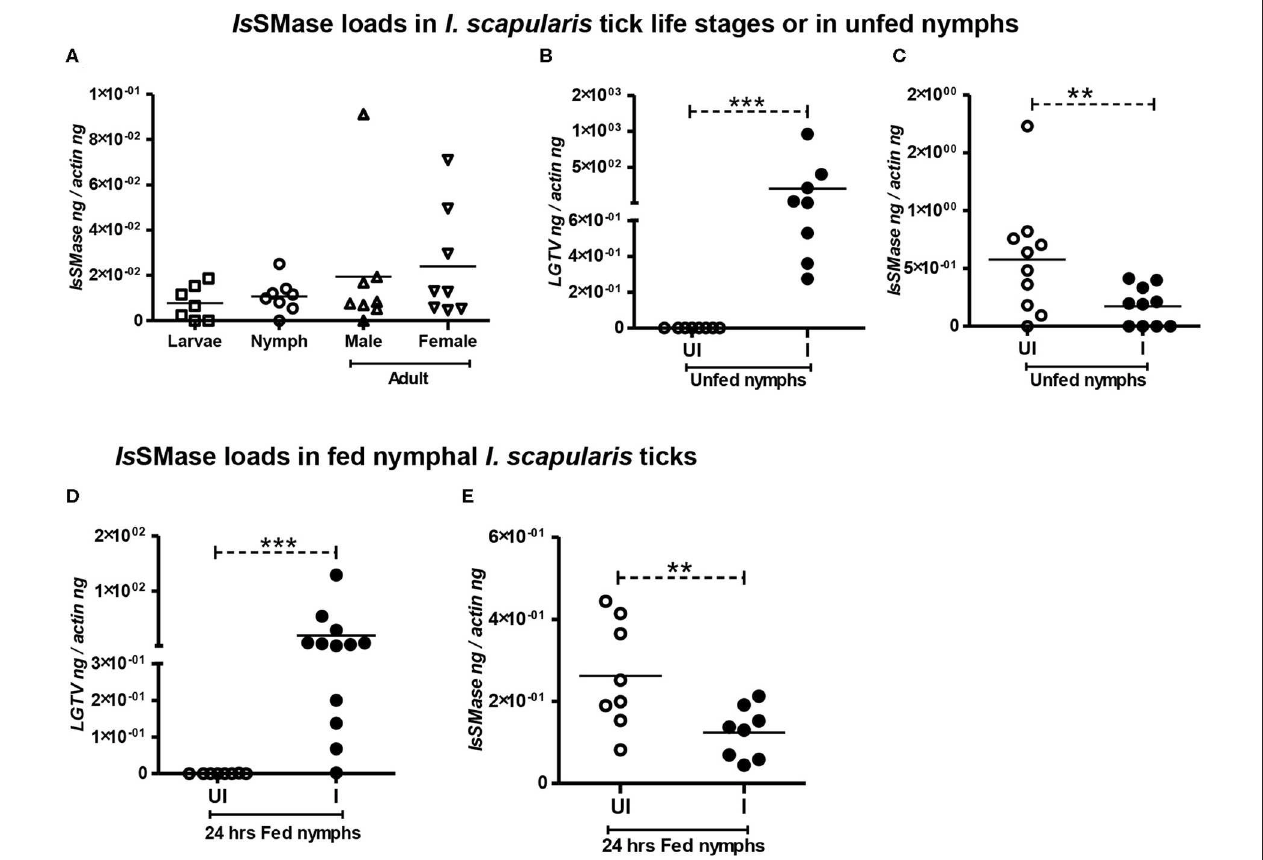
FIGURE 3 | Is SMase expression is reduced upon LGTV infection in ticks. QRT-PCR analysis showing Is SMase gene expression levels in different developmental/life stages (larvae, nymphs, adult male, and female) of ticks (A) . LGTV viral loads (B) or Is SMase transcript loads (C) in unfed nymphs is shown. QRT-PCR showing LGTV viral loads (D) or Is SMase transcript loads (E) in partially fed (24h) nymphs. UI indicates uninfected or I denotes LGTV-infected nymphs. Each square, circle, triangle, or inverted triangle indicates one tick. Open circles represent uninfected (UI) group, whereas closed circles denote LGTV-infected (I) group. LGTV loads or Is SMase mRNA levels were normalized to tick beta-actin levels. P -value determined by Student’s two-tailed t -test is shown. The asterisk indicates significance, and ** or *** denotes a P -value of less than 0.01 or 0.001,